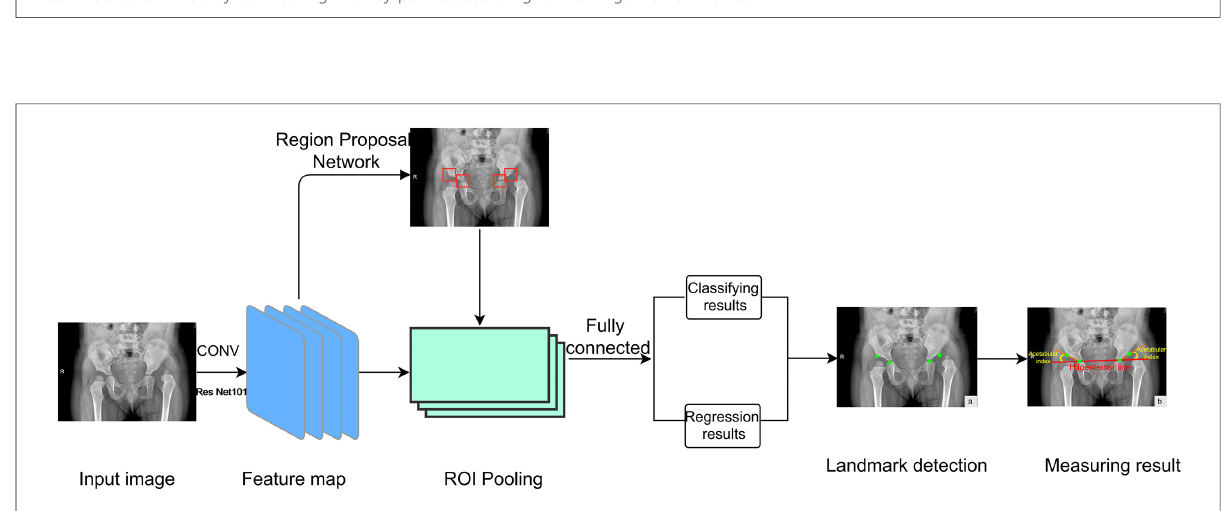
FIGURE 3 Illustration of standard pelvic plain fi lm labeling. The patient is an 18-month-old child ( A ) The green dots in the fi gure represent the key labeling points determined according to Hilgenreiner method, namely the Y-type cartilage center point and the acetabular lateral edge point; ( B ) The acetabular index was determined by connecting the key points according to the Hilgenreiner method.